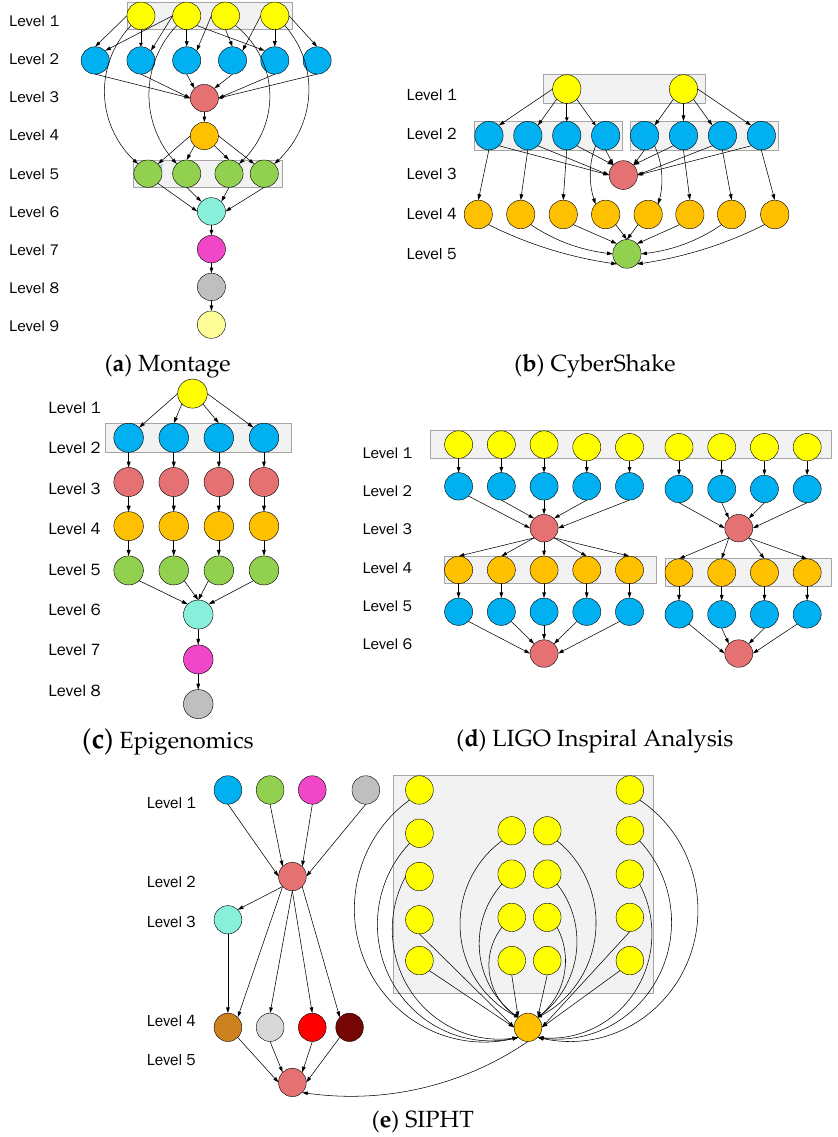
Figure 2. Examples of workflows after horizontal grouping. ( a ) Montage; ( b ) CyberShake; ( c ) Epigenomics; ( d ) LIGO Inspiral Analysis; ( e ) SIPHT. Table 2. Characteristics of the benchmark workflows. CU: Compute Unit.